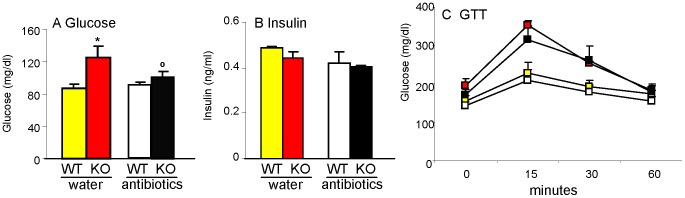
Effect of treatment with antibiotics.Chow-fed 8-week-old WT and Gal-3 KO mice received either regular drinking water (WT: yellow; Gal-3 KO: red) or water supplemented with antibiotics (WT: white; Gal-3 KO: black) for 4 weeks before measurement of fasting glucose (A), fasting insulin (B) and response to GTT (C) Data are mean+/−SEM, n = 5. *p<0.05 versus respective WT; °p<0.05 versus respective group without antibiotics (water).